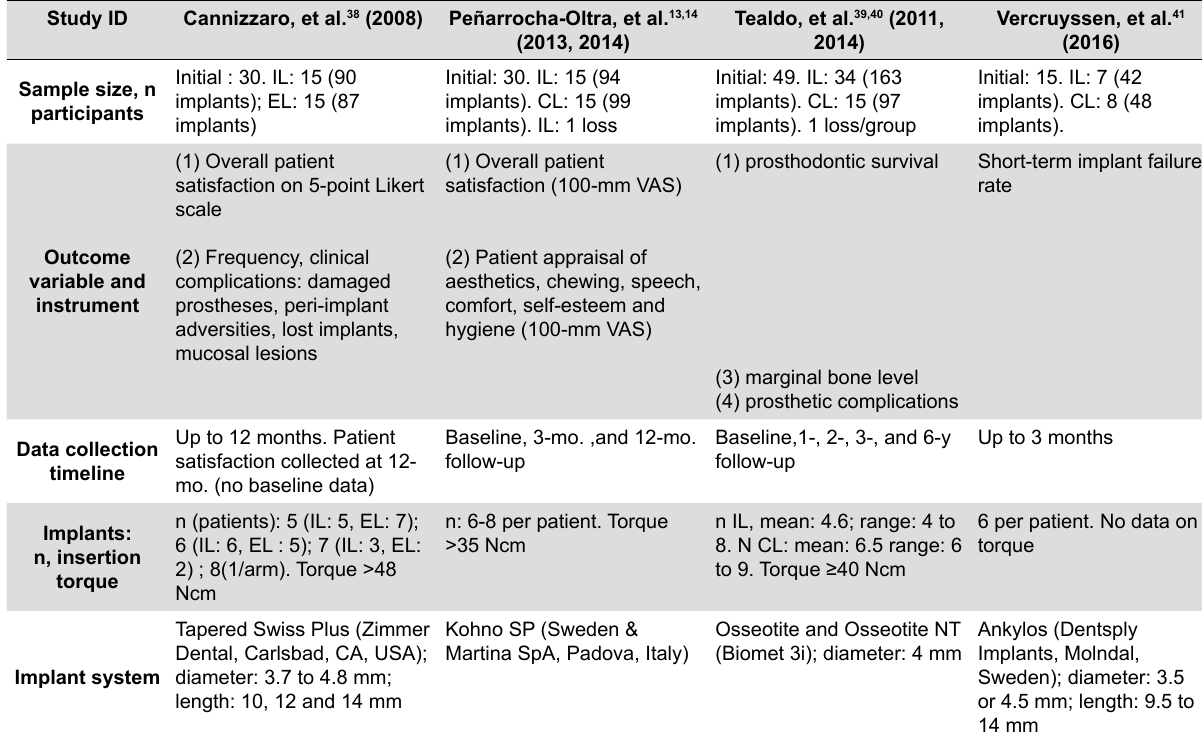
Table 1- Summary of the included study